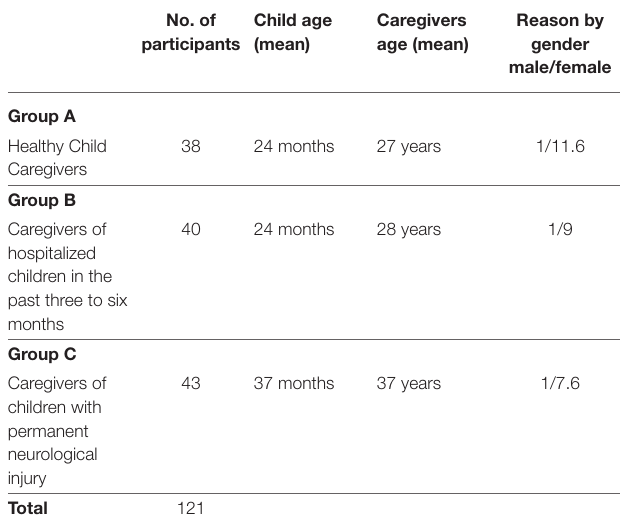
TABLE 1 | Characteristics of the participating